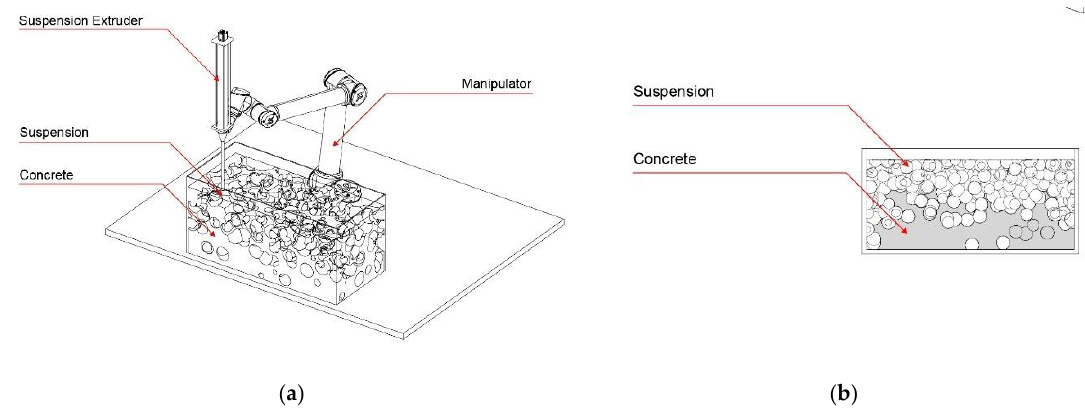
Figure 2. Suspension in Concrete (SiC): ( a ) fabrication process diagram; ( b ) printed graded element.